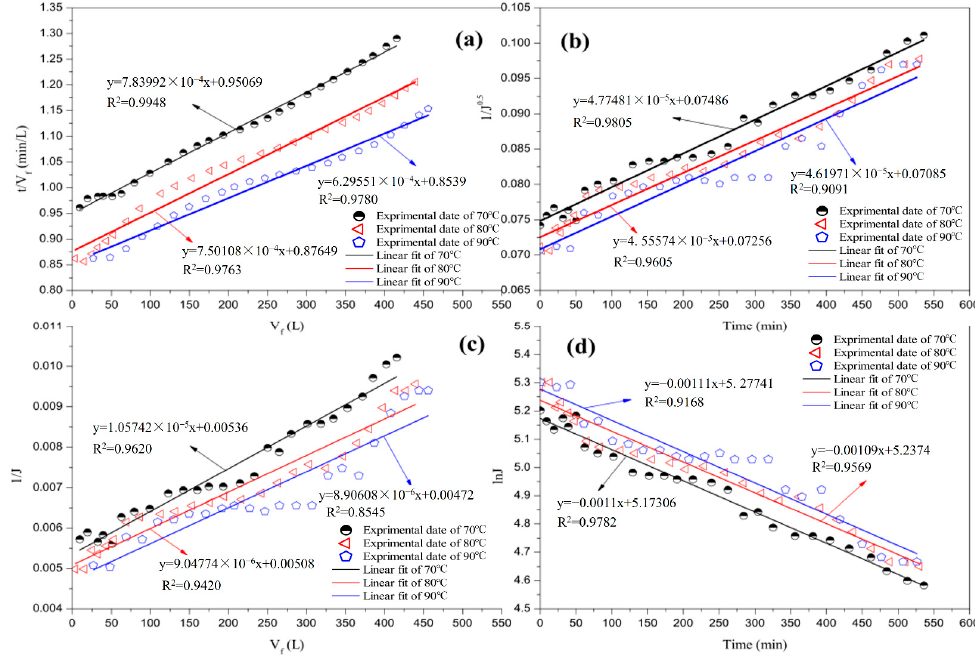
Figure 8. Linear fit with four fouling models at various temperatures: ( a ) cake filtration; ( b ) pore narrowing; ( c ) combination of external and progressive internal fouling; and ( d ) complete pore blocking. Table 8. R 2 values of regression by different temperatures for four fouling models.